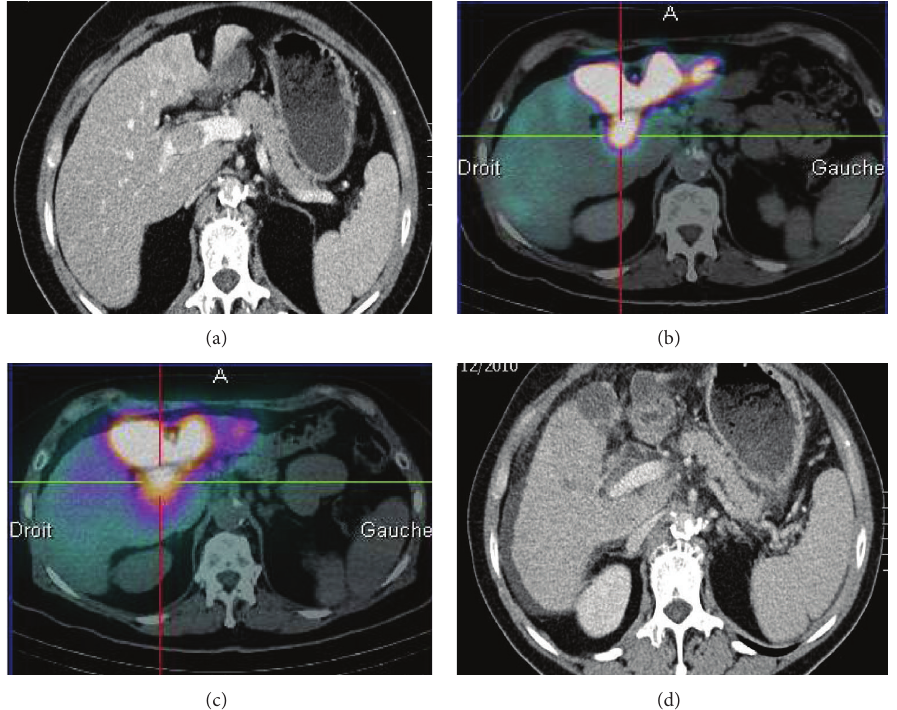
Figure 1: MAA SPECT/CT and CT scans showing implantation of microspheres in an PVTT and the involution of this PVTT after radi- oembolization: (a) Baseline CT scan, (b) MAA SPECT/CT showing a high MAA uptake in the PVTT, (c) Posttherapeutic Bremsstrahlung SPECT/CT after the injection of 4.5GBq of 90Y-loaded glass microspheres: high uptake in the PVTT confirming the accurate implantation of microspheres in the PVTT, and (d) CT scan at 13 months.